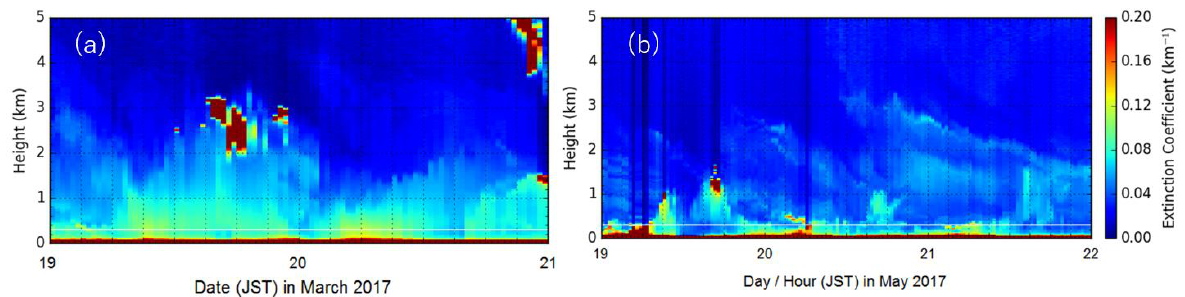
Fig. 4 Time-height indicator plot of the lidar data observed at 532 nm: (a) low RH case during March 19-20, 2017, and (b) high RH case during May 19-21,